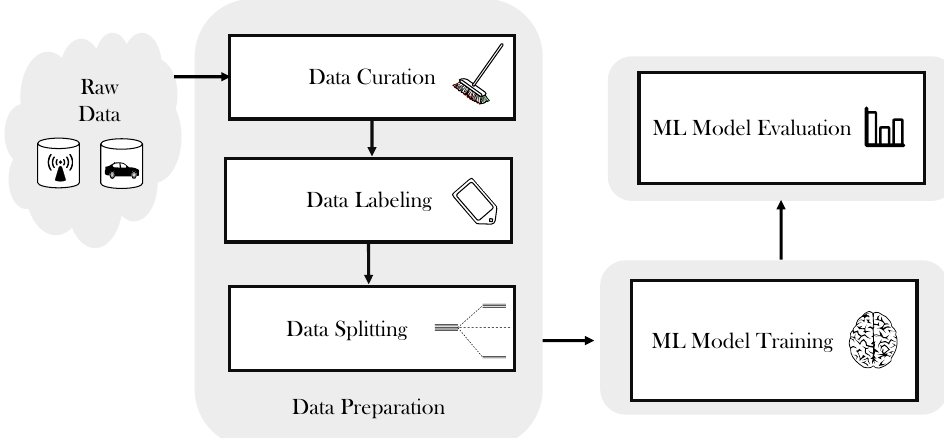
Figure 4. Building phases of the proposed ANN-based model.